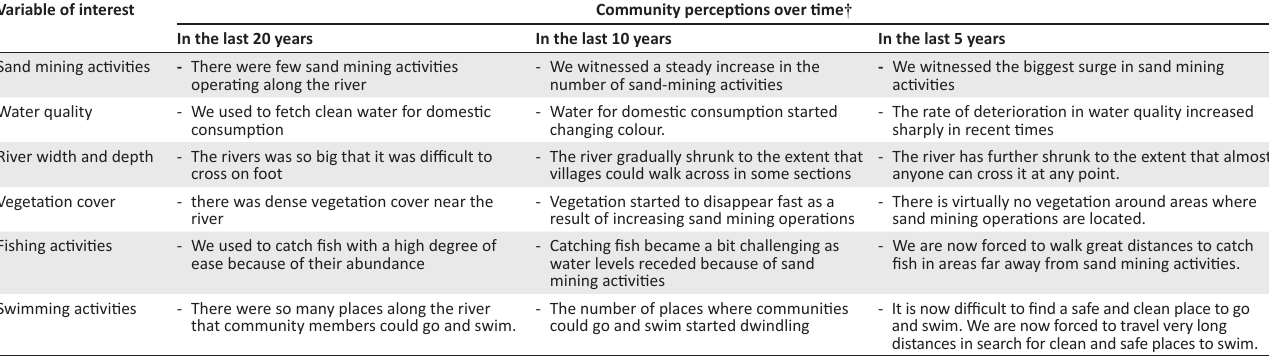
TABLE 3: Participatory historical time series analysis of sand mining impacts. Variable of interest